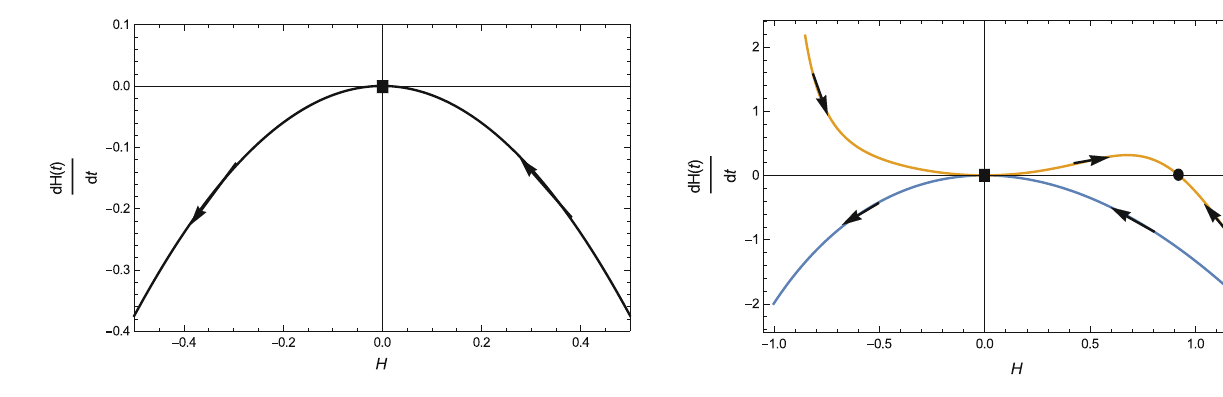
Fig. 14 Phase plot for C 1 = C 2 = 0. s = 1 Fig. 15 Phase plot for ω = 0. The yellow curve is for λ = 1 and the blue curve is for λ = − 1. C 1 and C 2 are chosen to be unity